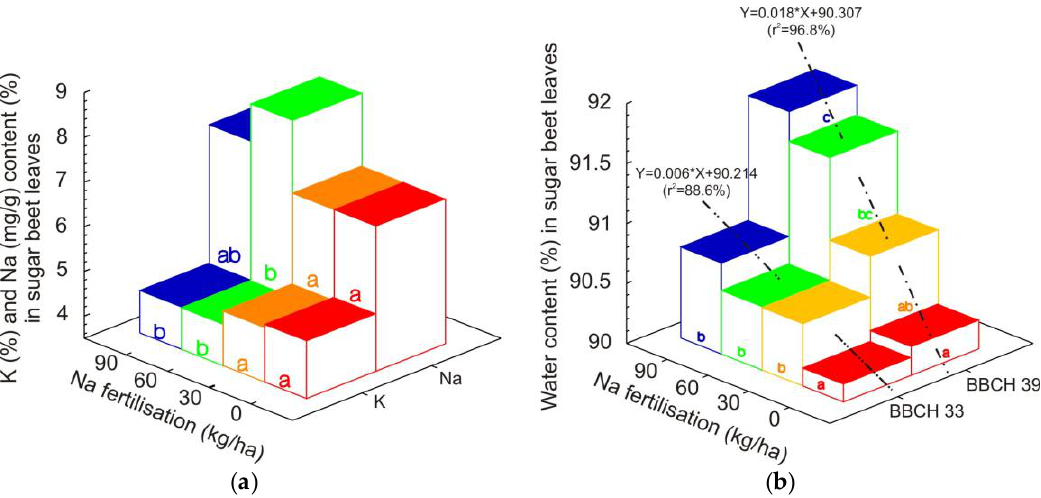
Figure 3. Influence of graded rates of Na (kg/ha) applied as NaCl on the K (%) and Na (mg/g) concentration ( a ), and water content (%) ( b ) of younger leaves of sugar beet at row closing (BBCH33 and BBCH39) at three experimental sites in northern Germany (extracted from [58,62]).